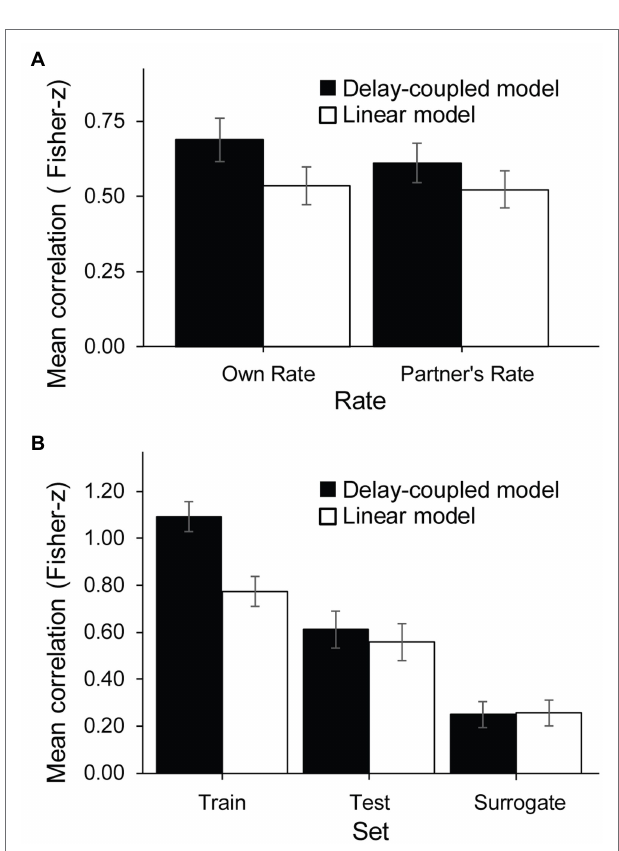
FIGURE 8 | Correlations of observed asynchronies with model predictions: significant interactions. (A) Rate × Model interaction. (B) Model × Set